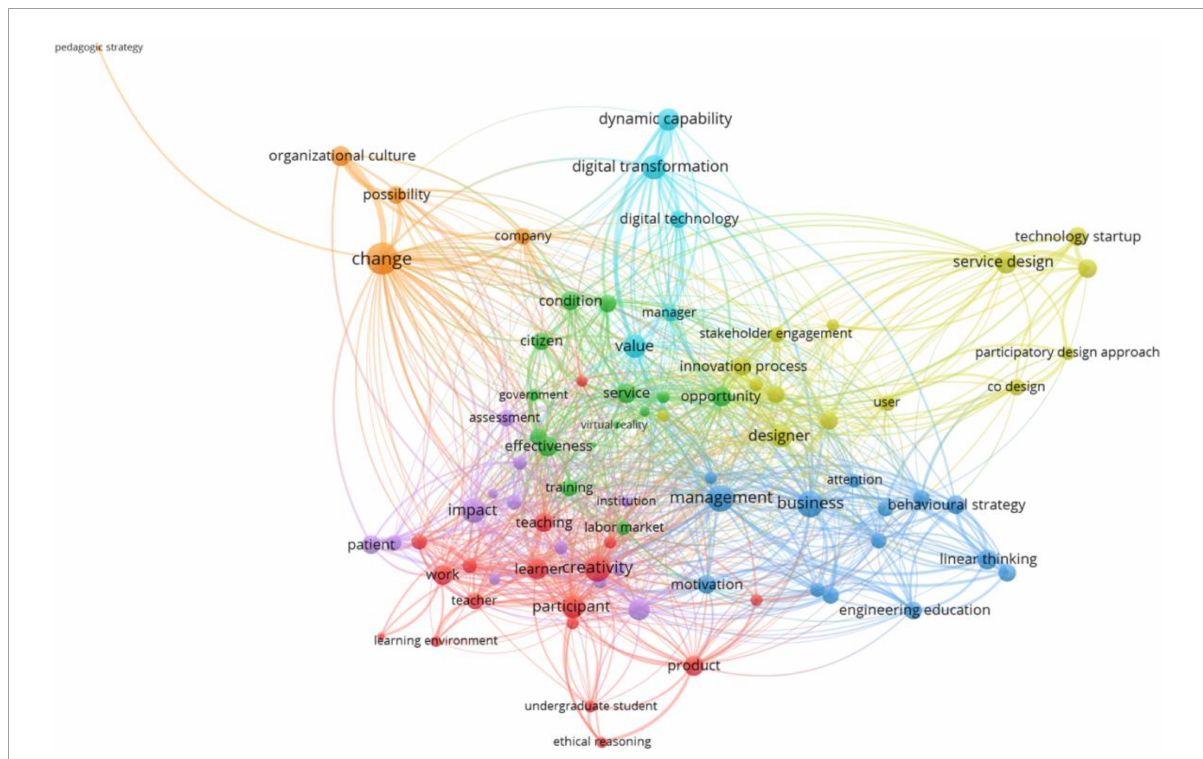
FIGURE3 Visualisation network of keyword co-occurrence in DT field related to (competencies in) digital era; co-word